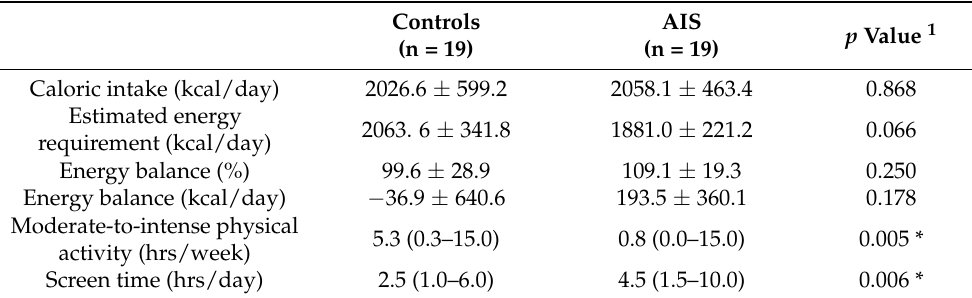
Table 3. Nutrition and physical activity of control and AIS